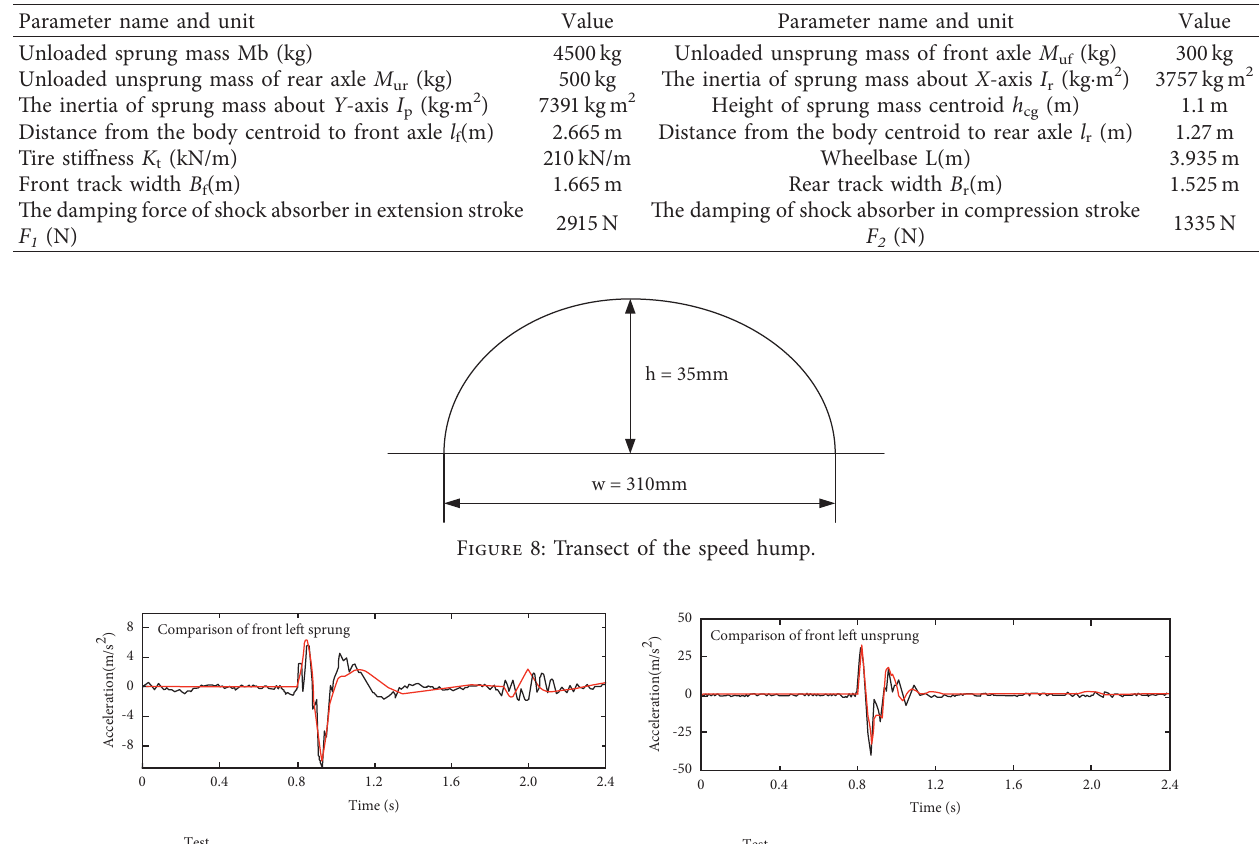
Table 1: Specifications of the model car.